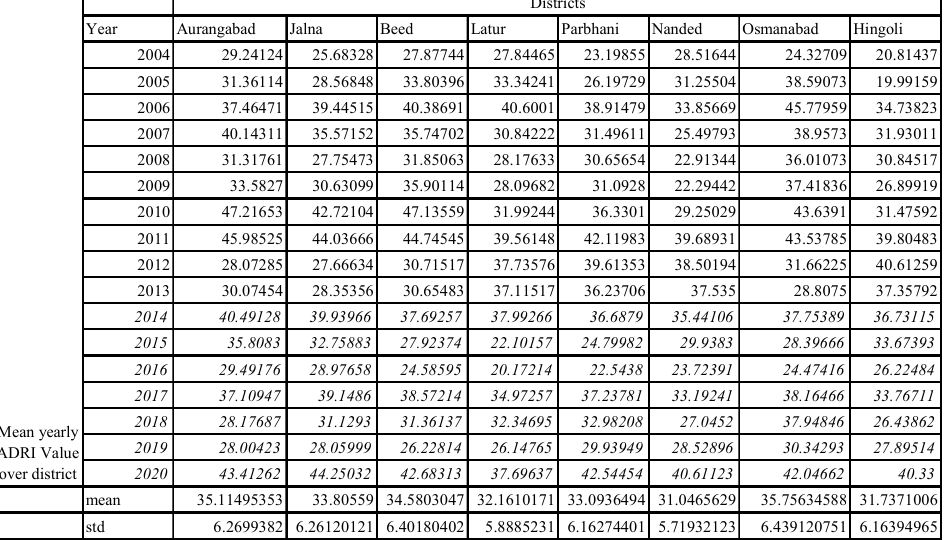
Table 1: Annual mean ADRI over every district of Marathwada from 2004 to